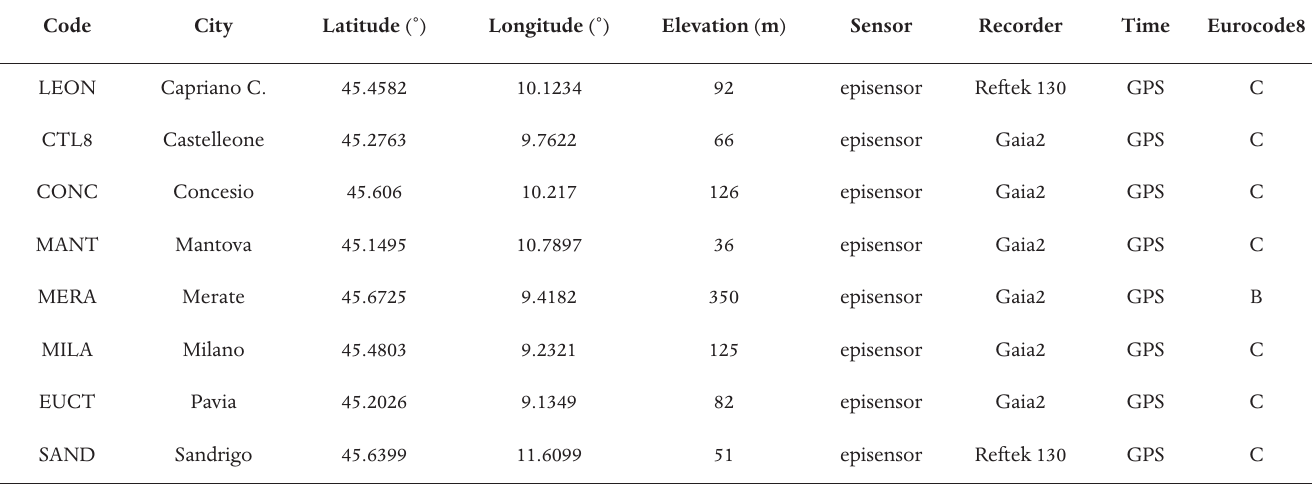
Table 1. Main features of RAIS stations considered in the present